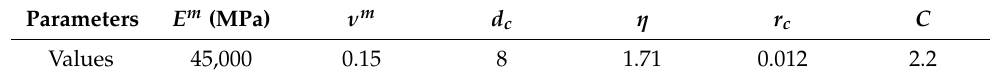
Table 3. Parameter’s values of Beishan